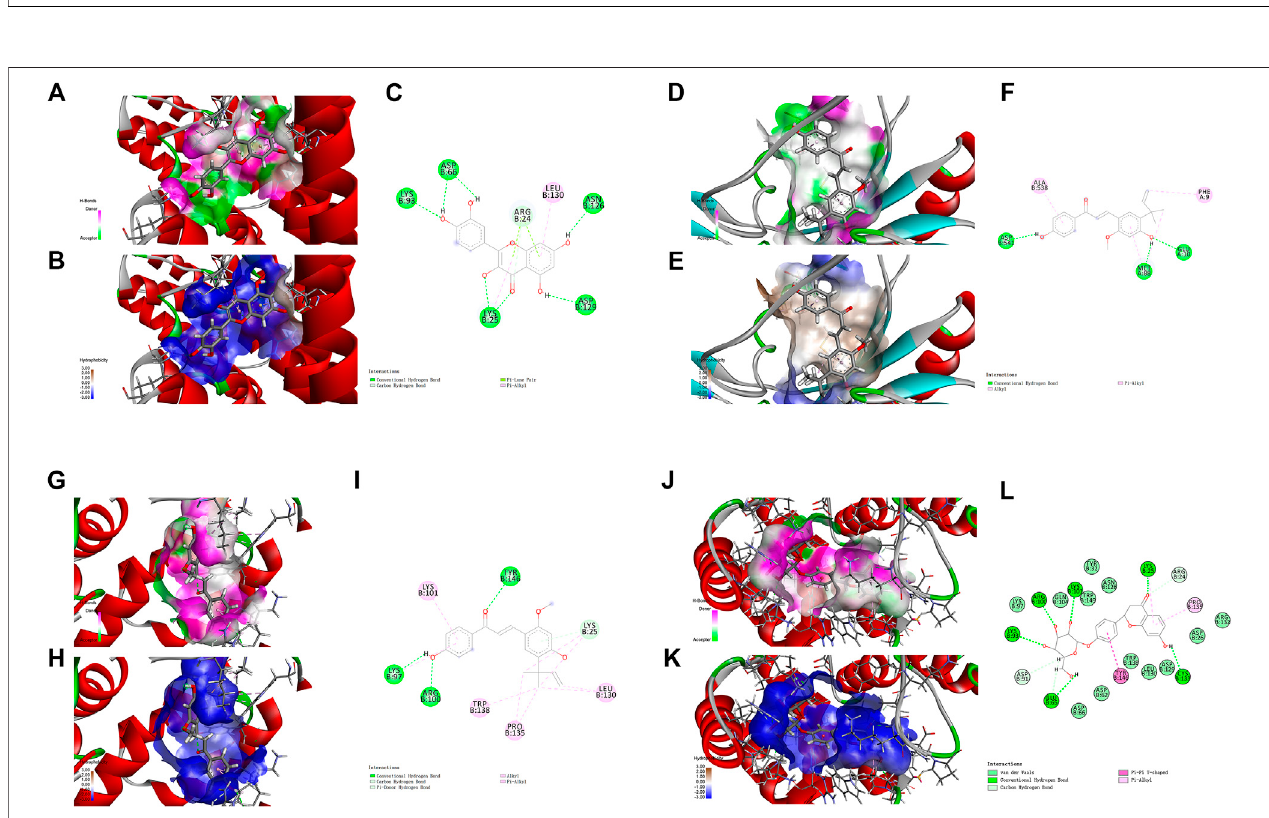
FIGURE 4 | Molecular docking analysis showing bond pattern of NF- κ B p65 and quercetin (A – C) , kaempferol (D – F) , licochalcone A (G – I) , liquiritin (J – L) . (A,D,G,J) : Areas of the donor and acceptor of hydrogen bond (H-bond). (B,E,H,K) : Areas of hydrophobicity. (C,F,I,L) : Two dimensional patterns of bond.